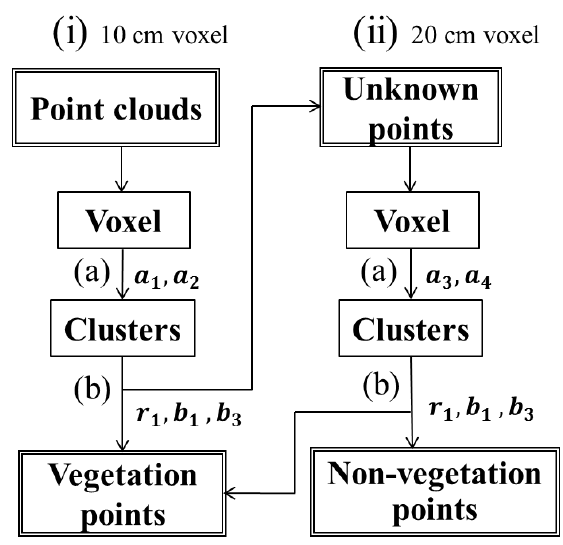
Figure 2. Flowchart of the proposed